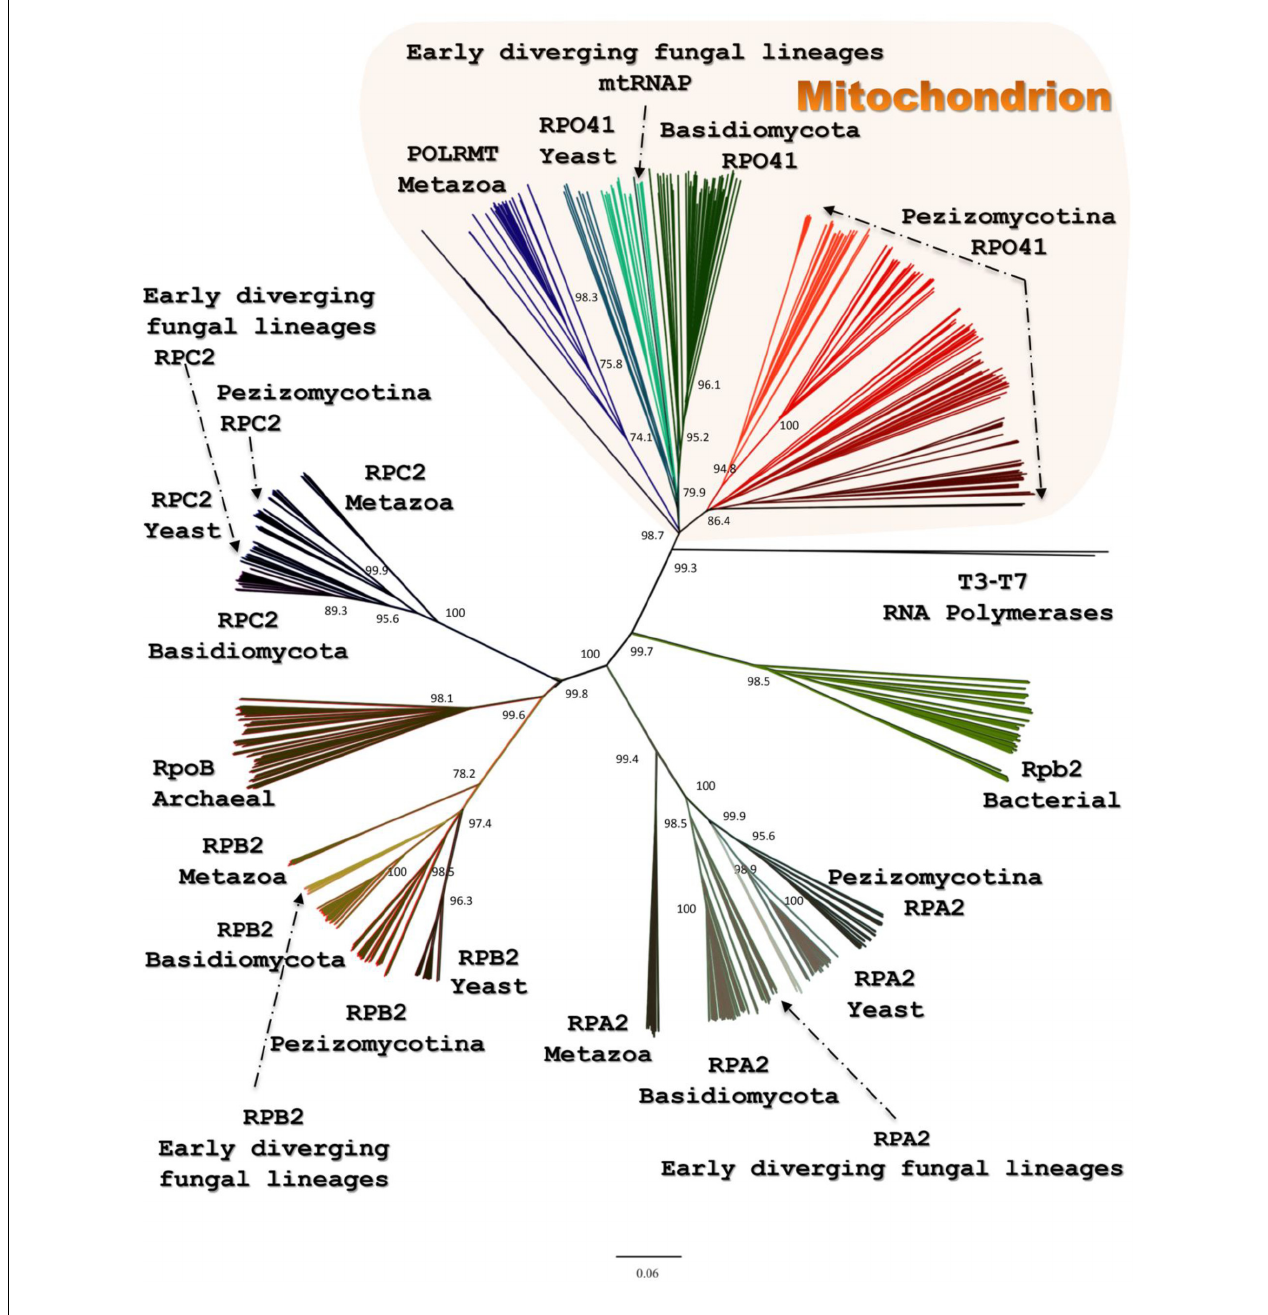
FIGURE 6 | The phylogenetic tree produced for Rpo41 and all homologs RNA polymerases from representatives of all living domains, using NJ and RaxML methods. Numbers at the nodes denote NJ-bootstrap support. RAxML-bootstrap was in all topologies above 90% and it is not